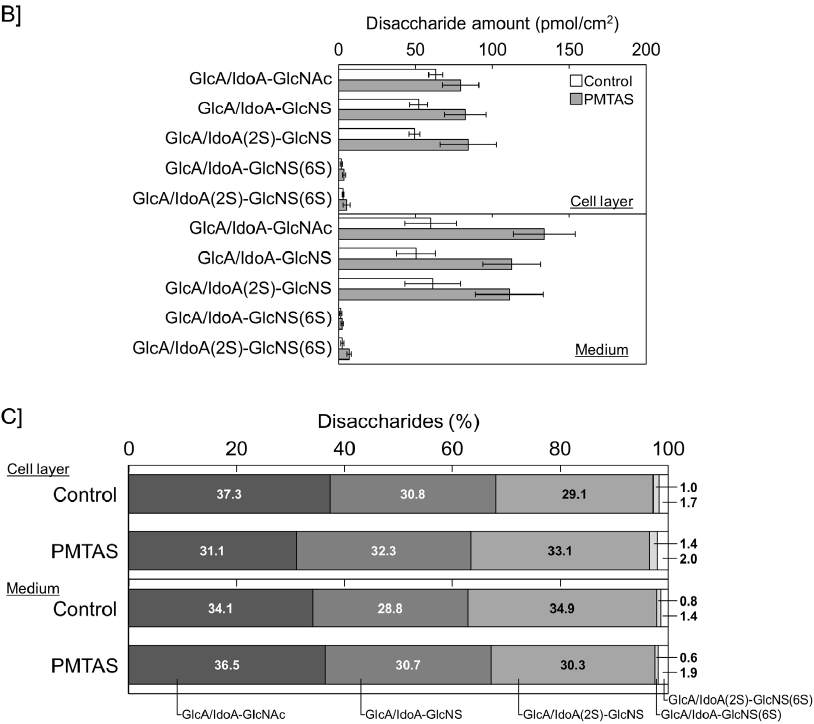
Figure 7. Fluorescence-assisted carbohydrate electrophoresis analysis of heparan sulfate accumulated in the cell layer and conditioned medium of dense cultures of vascular endothelial cells treated with PMTAS (10 µM) for 48 h: ( A ) A representative gel image; ( B ) disaccharide composition of heparan sulfate chains, values are means ± S.E. of four independent samples; ( C ) the percentage of the disaccharide units in heparan sulfate chains.